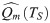
Schematic representation of MSQ analysis procedure.(A) The decaying fluorescence intensity trace is divided into M segments. Each segment has a length of T
S. (B) The Q-value Qm^(TS) is calculated from the photon count data of each segment, followed by the calculation of the mean of the segmented Q-values MSQ(T
S). (C) The above steps are repeated for different segment lengths to calculate MSQ as a function of T
S. Conventional FFS theory predicts that MSQ is independent of the segment length (solid line). The presence of photodepletion and estimator bias introduces curvature into the MSQ-curve (triangles).